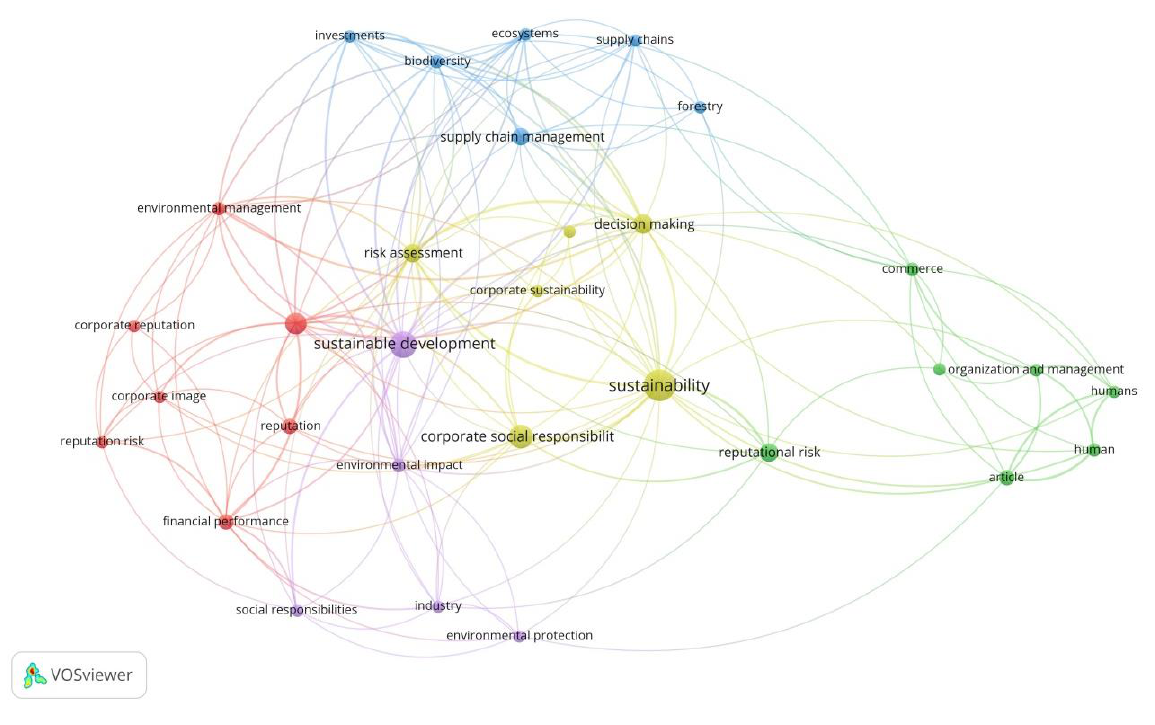
Figure 6. Searched keywords.